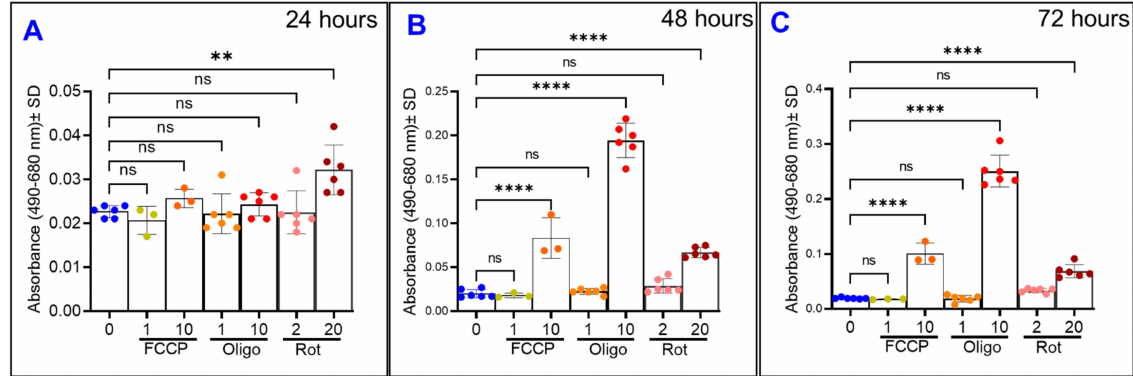
Figure 11. Effects of mitochondrial inhibitors on ARPE-19 cell viability. Lactate dehydrogenase (LDH) cytotoxicity assays were done at T = 24, 48, and 72 h after initiation of treatment. ( A ) LDH release of the cell groups 24 h after experiment start. Only rotenone 20 µ M is associated with increased LDH release. ( B ) LDH release at T = 48 h. At this time, the FCCP 10 µ M and oligomycin 10 µ M have joined the rotenone 20 µ M with associated increased LDH release. ( C ) LDH release of the cell groups at 72 h. Abbreviations: FCCP, trifluoromethoxy carbonylcyanide phenylhydrazone; Oligo, oligomycin; Rot, rotenone; ns, no significance. Data shown are the mean ± SD of 5–6 independent biological replicates per group. p values are ** p ≤ 0.01 and **** p ≤ 0.0001.